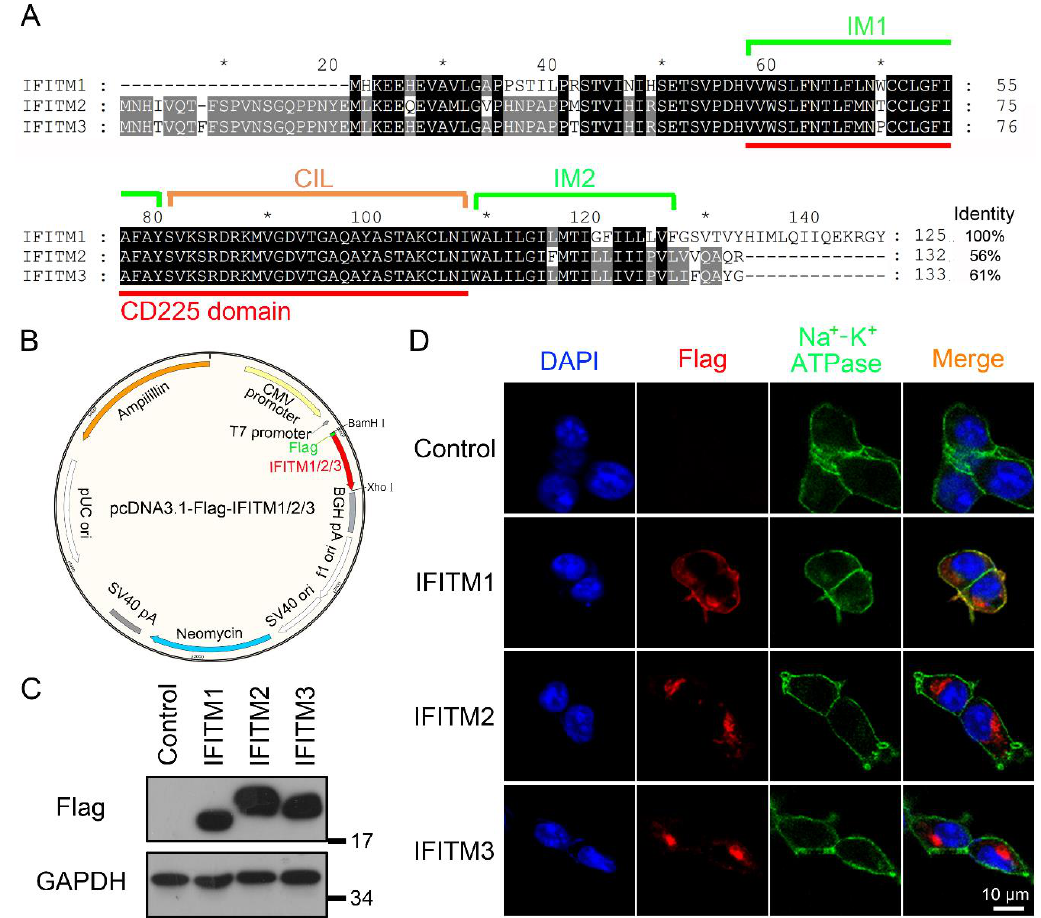
Figure 1. The subcellular localization of IFITM1 / 2 / 3 in HEK293T cells. ( A ) The amino acid sequence alignment of IFITM1, IFITM2 and IFITM3. Predicted intramembrane domain 1 (IM1) and intramembrane domain 2 (IM2; green line), conserved intracellular loop (CIL; orange line) and CD225 domain (red line). ( B ) The plasmid map of pcDNA3.1-Flag-IFITM1 / 2 / 3. The map was drawn with SnapGene. ( C ) The overexpression analysis of Flag-IFITM1 / 2 / 3 in HEK293T cells; pcDNA3.1 and pcDNA3.1-Flag-IFITM1 / 2 / 3 were transfected in HEK293T cells, respectively. After 24 h, cells were collected, and the expression level of intracellular IFITM1 / 2 / 3 was analyzed by Western blotting using anti-Flag antibody. ( D ) The colocalization of IFITM1 / 2 / 3 and Na + -K + ATPase in HEK293T cells; pcDNA3.1 and pcDNA3.1-Flag-IFITM1 / 2 / 3 were transfected in HEK293T cells. After 24 h, cells were stained with anti-Flag antibody, anti-Na + -K + ATPase antibody and DAPI. Then, cells were observed using confocal microscopy. Flag-IFITM1 / 2 / 3, red; Na + -K + ATPase, green; DAPI,